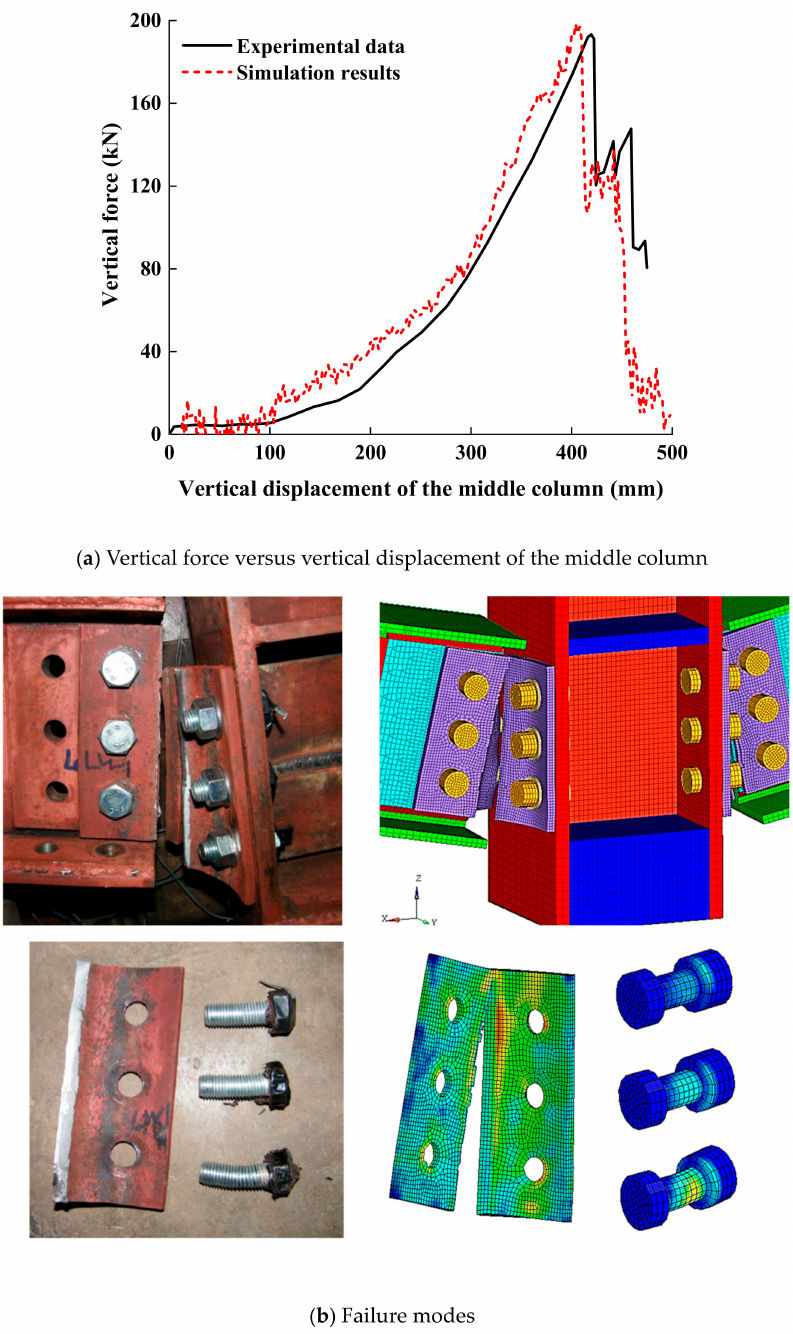
Figure 6. Comparison between simulation and experimental results of W-10 subjected to loss of a middle